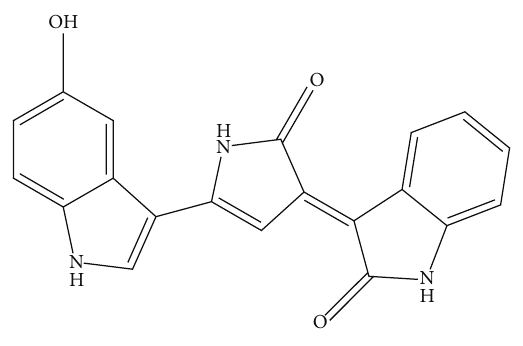
Figure 1: Structure of